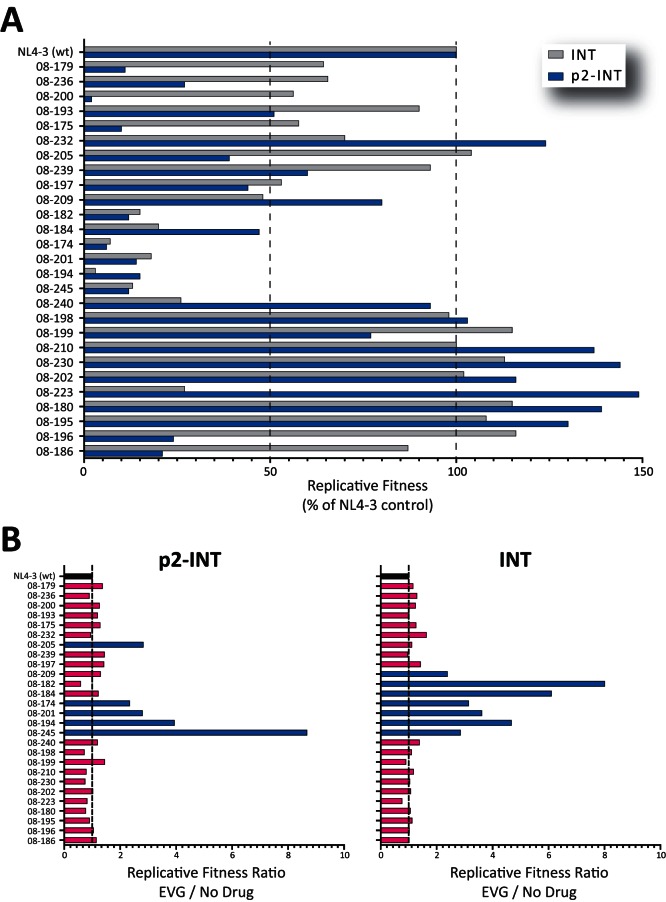
Growth competition experiments to determine replicative fitness of multidrug-resistant p2-INT- and INT-recombinant viruses in the absence and presence of drug pressure.p2-INT- and INT-recombinant viruses were constructed using patient-derived PCR products from 27 highly treatment-experienced individuals participating in the GS-US-183-0105 study of elvitegravir. Each recombinant virus was competed against the HIV-1NL4-3 control in the absence (A) or presence (B) of EVG (0.01 nM) and their replicative fitness calculated and expressed as a percentage of the replicative fitness of the reference virus (HIV-1NL4-3) as described [55], [69]. Values represent results obtained from single growth competition experiments. The Ratio of Replicative Fitness was calculated as described in the legend of Figure 3.